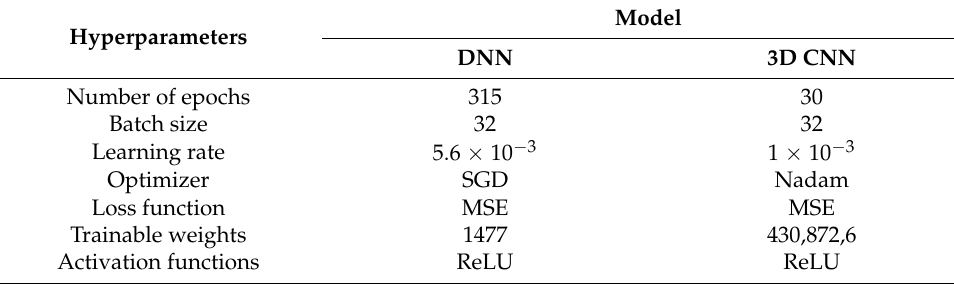
Table 1. Hyperparameters values used in the proposed